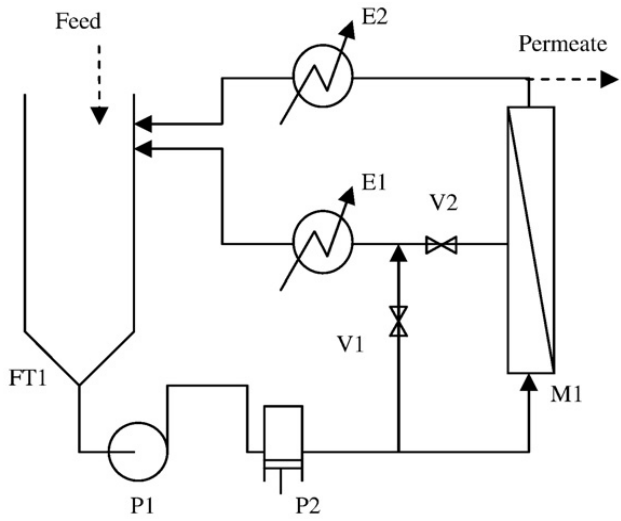
Figure 1. Scheme of the used membrane pilot